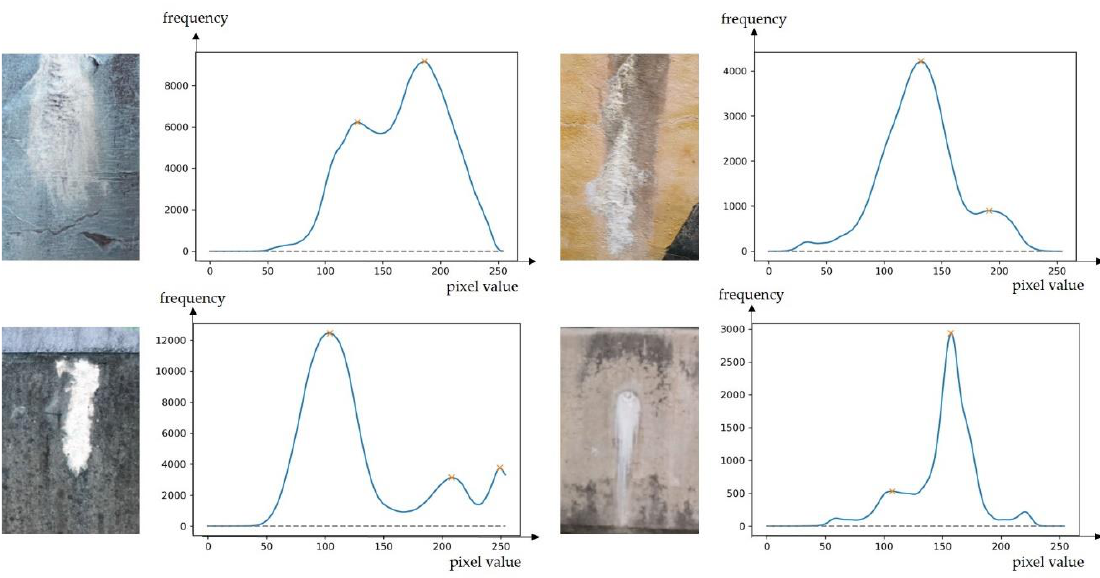
Figure 11. Efflorescence images and their histograms.